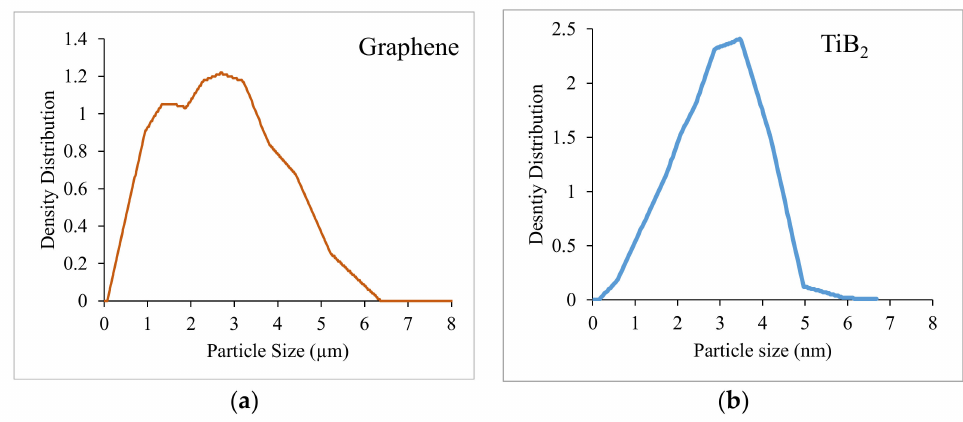
Figure 7. Particle size analysis of ( a ) Graphene and ( b ) TiB 2